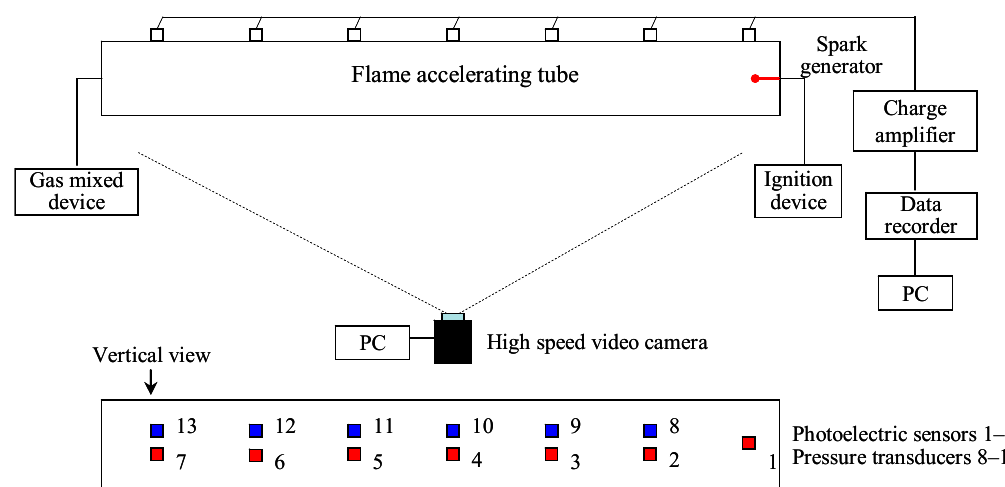
Figure 1. Schematic of the experimental system.